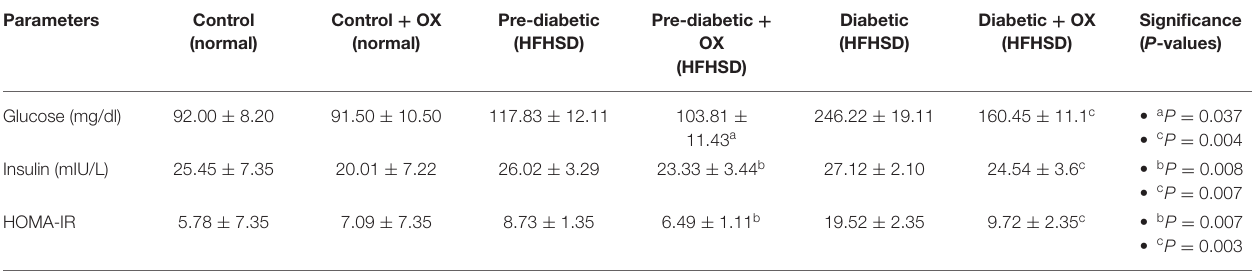
TABLE 1 | Effect of oxytocin administration on serum glucose, insulin conc., and HOMA-IR in different groups of Wistar rats. Parameters Control (normal)